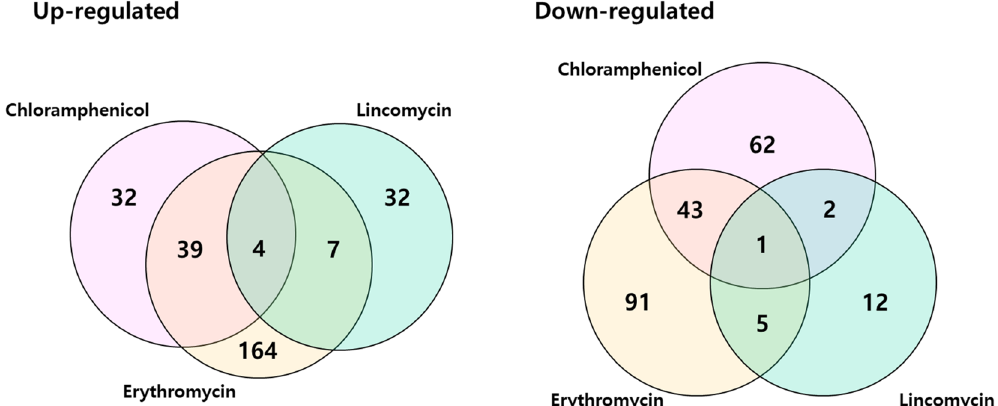
Figure 3. Venn diagram of differentially expressed genes (DEGs) of S. equorum strain KM1031 following treatment with chloramphenicol, erythromycin and lincomycin. Overlapping regions represent genes that were differentially expressed in strain KM1031 (compared with untreated cells) on treatment with two or three of the antibiotics. The numbers outside overlapping regions indicate the numbers of significantly differentially expressed genes that were affected by each antibiotic